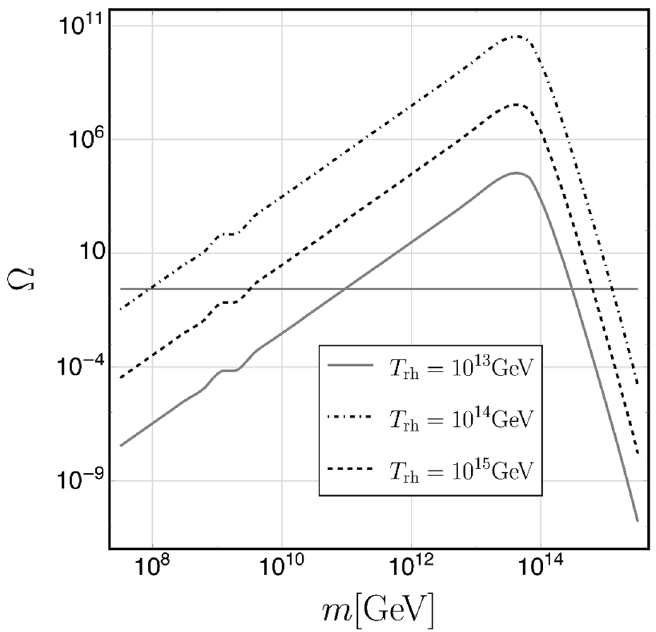
Figure 10 . Abundance of dark matter for the conformal coupling case ( (cid:24) = 1 = 6) for di(cid:11)erent reheating temperatures. The solid horizontal line represents the observed abundance (cid:10) = 0 : 268. The gap between the allowed masses grows larger as the reheating temperature is